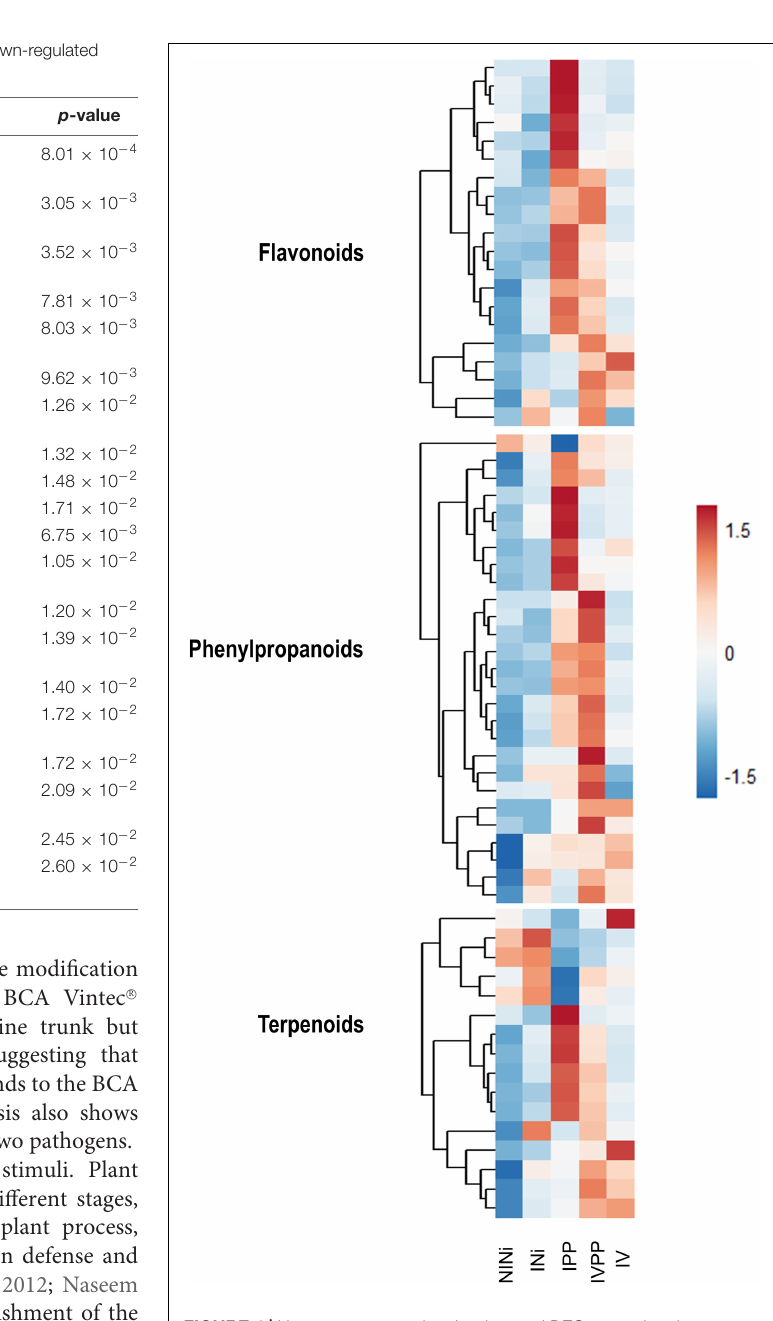
FIGURE 4 | Heatmap representing the detected DEGs associated to flavonoids, phenylpropanoids and terpenoids biosynthesis. The color key represents the log2 relative gene expression values. Each line represents one gene, and each column represents one